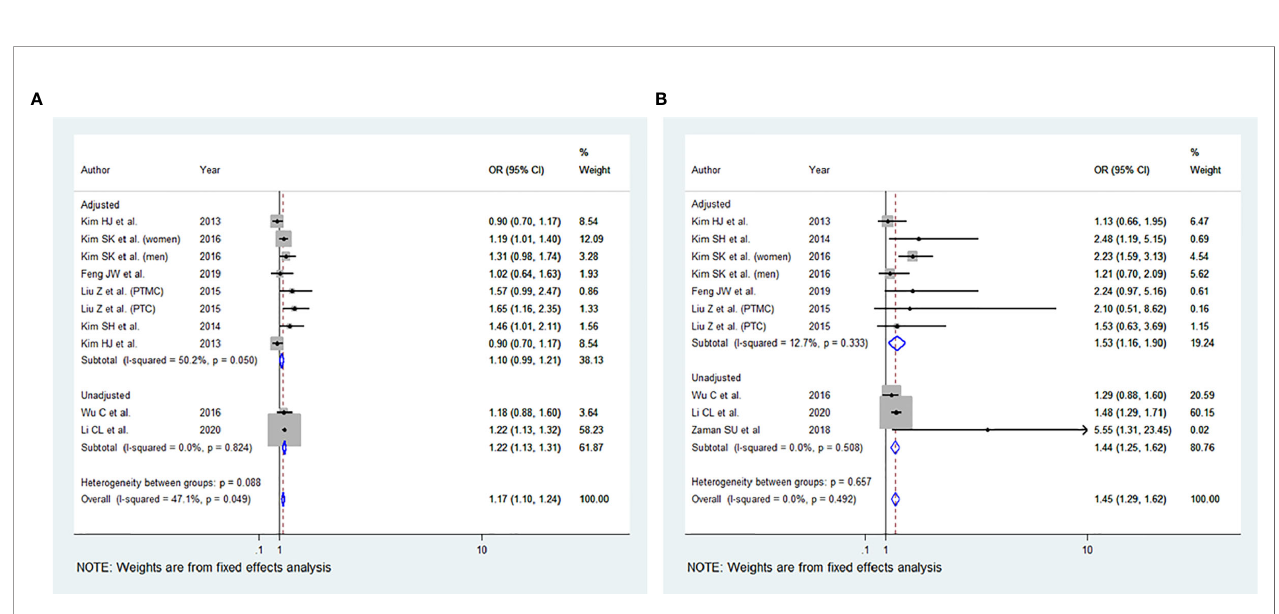
FIGURE 4 | Forest plots for the meta-analysis for the association between Body Mass Index and Extrathyroidal Extension (ETE). (A) Meta-analysis between overweight and ETE. (B) Meta-analysis between obesity and ETE.